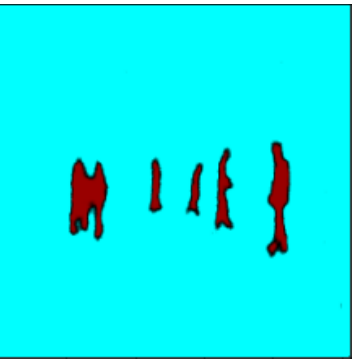
Figure 20. The fusion of the three images corresponding to the lidar, radar, and RGB is shown in red. The target and prediction during training were stored in a vector. Later on, the intersection over union (IoU) was evaluated for each frame to see the percentage of the overlapping area between the prediction and the target. To this end, to evaluate the results of the network in training mode, pixel accuracy and intersection over union (IoU) metrics for the image segmentation were used. Additionally, the cross-entropy loss function was